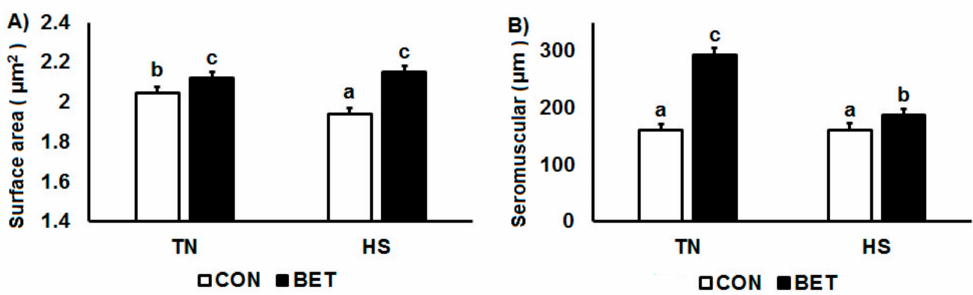
Figure 5. Ileal morphology: ( A ) villous surface area and ( B ) seromuscular layer in broilers during a thermoneutral (TN) vs. heat stress (HS) environmental challenge. Broilers were fed either a control diet (CON) or betaine diet (BET) and the mean represents the main e ff ect at 5 time points (1, 2, 3, 7 and 10 day challenge). Means with di ff ering superscripts denote p < 0.05. Refer to Table 2 for full interactive e ff ects.